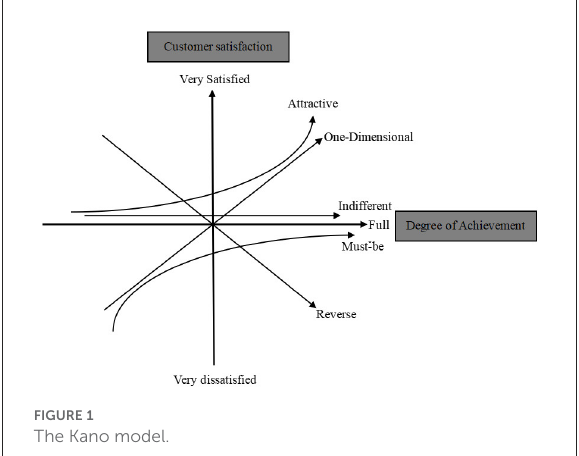
FIGURE1 The Kano